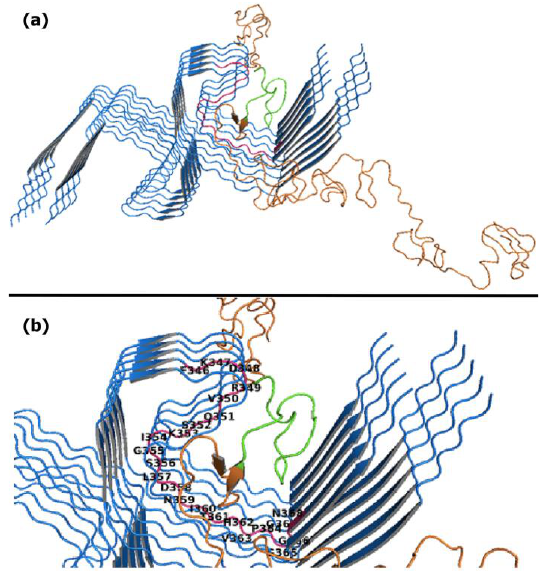
Figure 2. Results from ClusPro modeling showing the interaction between PHF tau and LRP1 Cluster 2 (CCR2) domain. The 23-amino-acid segment SKAWVCDGDNDCEDNSDEENCES is shown in green. The LRP1 binding pocket identified from this model is outlined in pink. ( a ) Shows the inter- actions with the entire CCR2 domain with PHF Tau. ( b ) Close-up image showing residues of the binding pocket (in pink).